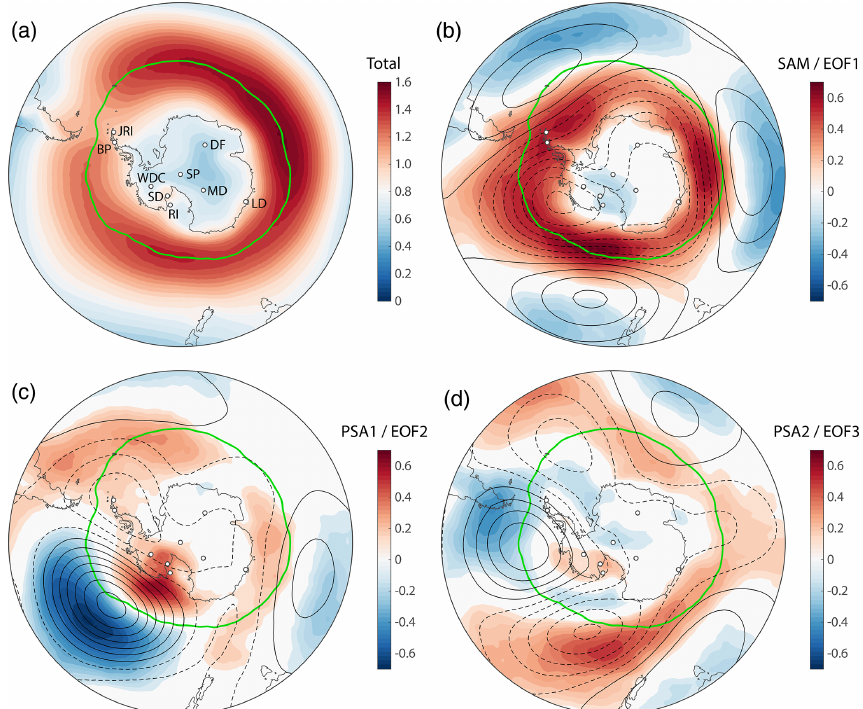
Figure 5. Modes of SH extratropical atmospheric variability and their link to synoptic-scale surface pressure variability in Antarctica. (a) Annual mean (cid:56) in units of percent per day (%d − 1 ). (b) Colors show correlation between (cid:56) and the southern annular mode (SAM) index, with the 500hPa geopotential height anomalies superimposed in 10m contours (positive contours solid, negative contours dashed). (c) As panel (b) , but for the Pacific–South American Pattern 1 (PSA1). (d) As panel (b) , but for the Pacific–South American Pattern 2 (PSA2). SAM, PSA1, and PSA2 are defined as the first, second, and third EOFs (empirical orthogonal functions), respectively, of the 500hPa geopotential height anomalies in 20–90 ◦ S monthly values in the 1979–2017 ERA-Interim reanalysis (Dee et al., 2011). In all panels the latitude of maximum (cid:56) is denoted by the green line. Table 2. Pearson correlation between (cid:56) at the ice coring sites and large-scale atmospheric circulation. Correlations are calculated using annual mean data (all months, April–March). We only list the statistically significant correlations ( p < 0 . 1). The Niño 3.4 is calculated